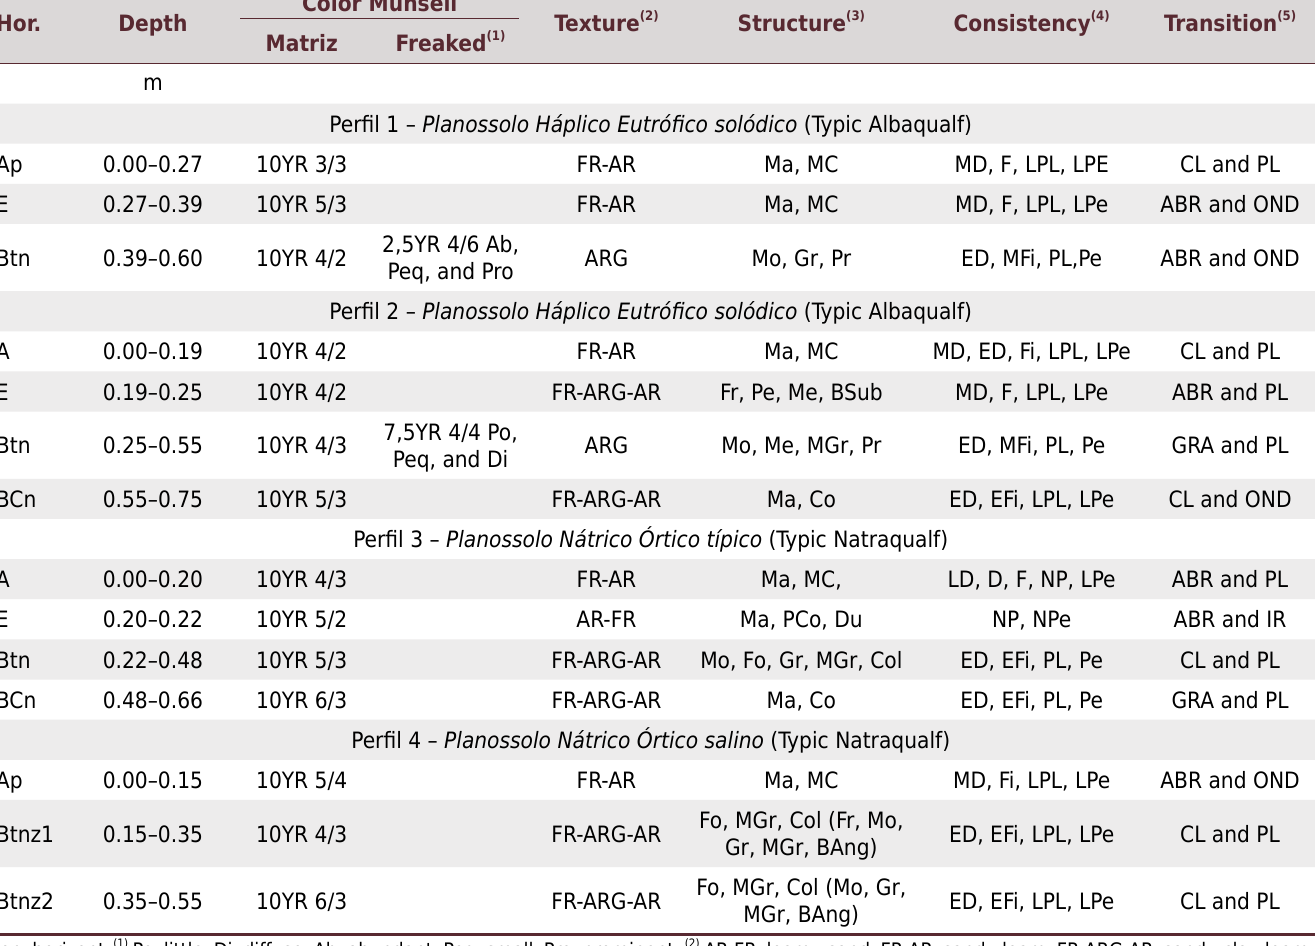
Table 1. Description of morphological attributes studied in Planosols located in different geo-environmental conditions Hor.